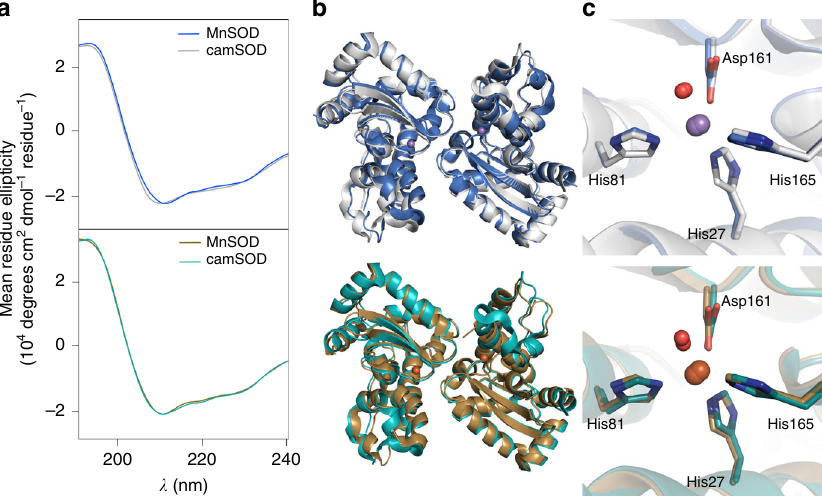
Fig. 1 Extensive structural similarity of S. aureus MnSOD and camSOD. a Overlaid CD spectra ( n = 1) of the (upper panel) manganese-loaded (MnSOD in blue; camSOD in gray) and (lower panel) iron-loaded (MnSOD in gold; camSOD in teal) isoforms, demonstrating similar secondary structure content of the two isozymes in solution. b Superimposed crystal structure cartoons of (upper panel) manganese-loaded forms 24 and (lower panel) iron-loaded forms of each enzyme, with the proteins colored as per panel ( a ), and with manganese ions, iron ions, and waters shown as purple, orange, and red spheres, respectively. Analysis of all four structures show that the polypeptide backbones of all isoforms of the staphylococcal SODs are essentially identical to within the ~2 Å resolution of the structural data (Supplementary Tables 3 – 5). c No signi fi cant differences within the structural resolution were detectable in the metal coordination environment that could explain the disparate metal speci fi city of their catalysis.